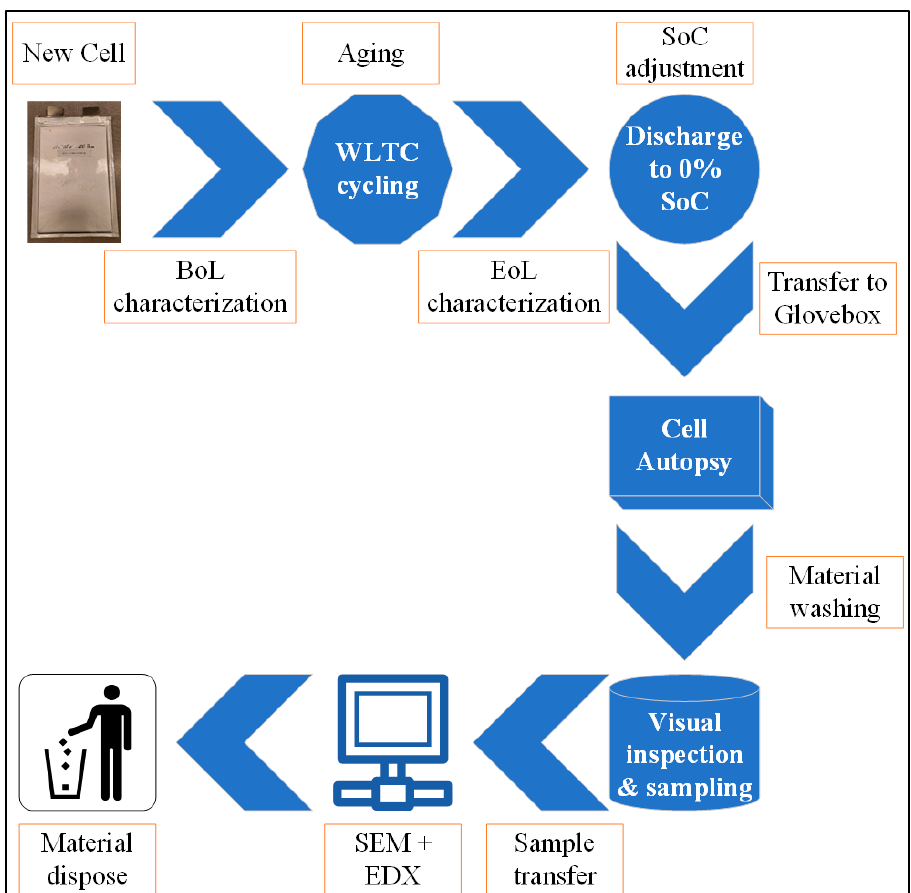
Figure 4. Full investigation flowchart including a post-mortem of the studied NMC 20 Ah Cell01.